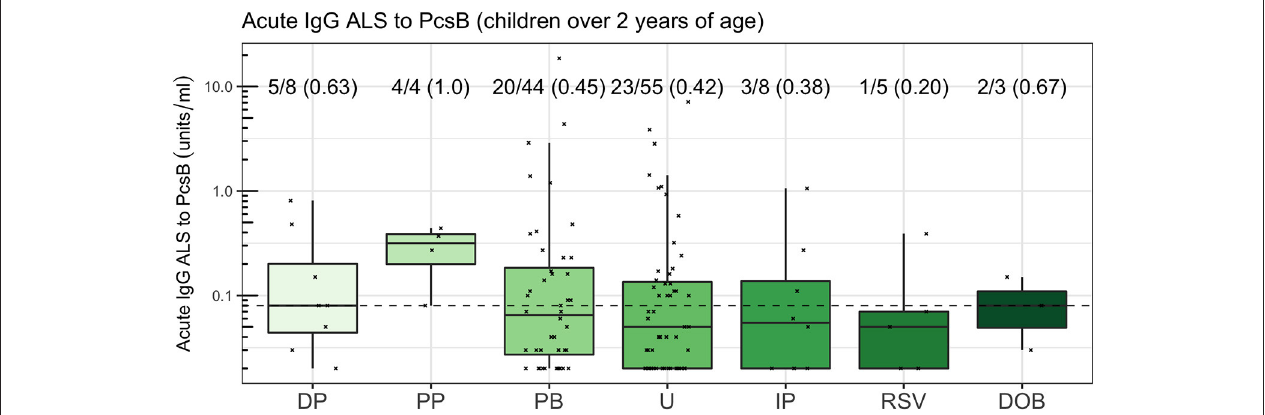
FIGURE 8 | Acute IgG ALS to PcsB by comparator group in children ≥ 2 years of age. The dotted horizontal line represents a threshold of 0.08 units/ml, the threshold derived from the Youden Index. The proportion of children with acute IgG ALS to PcsB concentration greater than, or equal to, the threshold derived from ROC curve analysis to discriminate pneumococcal pneumonia from non-pneumococcal pneumonia is